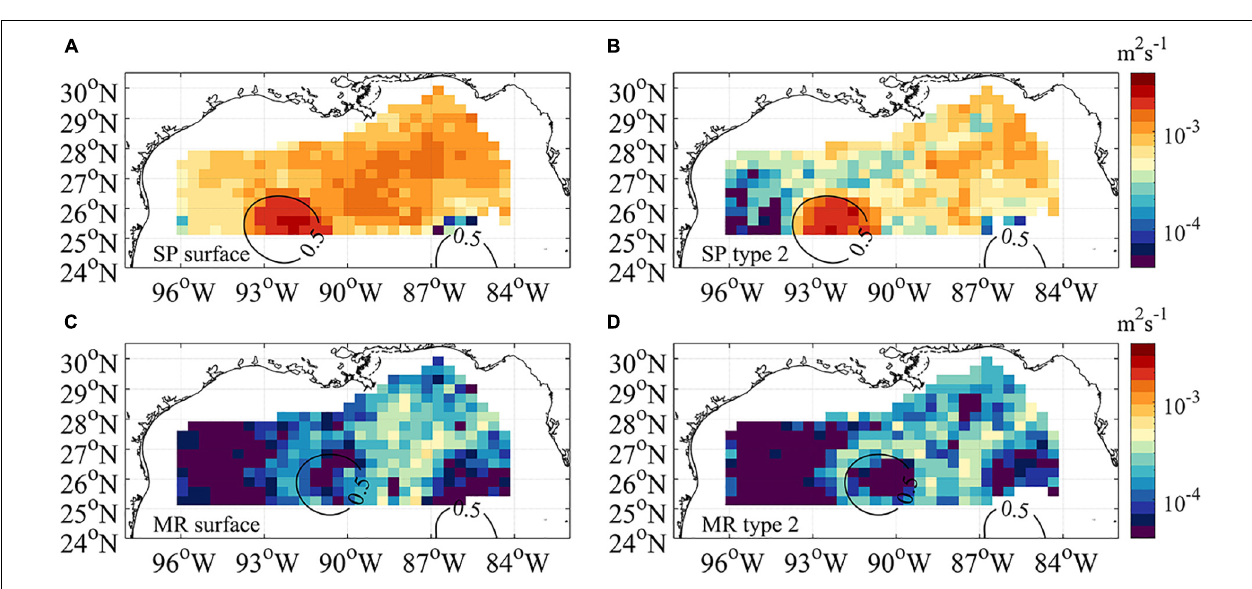
FIGURE 13 | Maps of binned vertical diffusivity for surface (A,C) and type 2 (B,D) releases at the two model resolutions [SP (A,B) ; MR (C,D) ] in February. Particles are first binned based on their initial location. The 10 days particle trajectories of each bin are then used for diffusivity calculation. Results from day 4 to 10 are averaged and denote the diffusivity for each bin. Contours are 0.5 m SSH